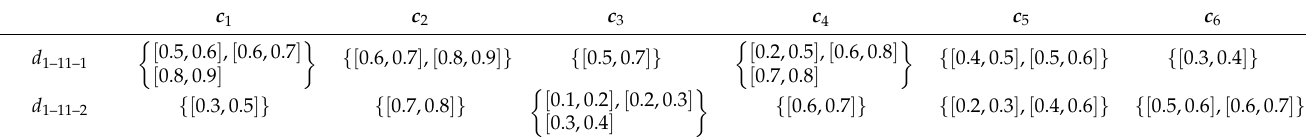
Table A11. Scoring matrix of asset risk d 1–11 .